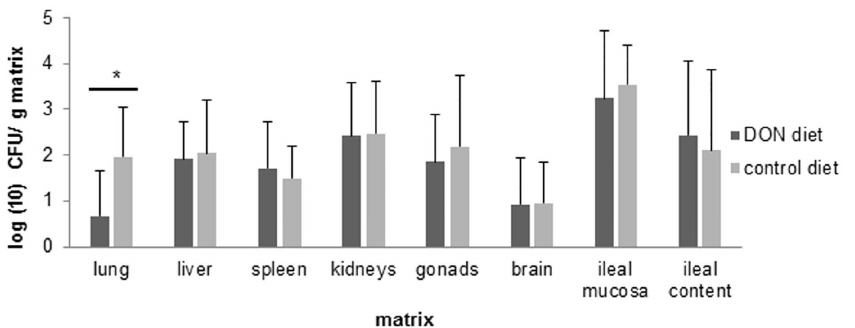
Fig 4. Salmonella numbers in organs. Thirteen days post inoculation with Salmonella Typhimurium variant Copenhagen strain DAB69, birds were euthanized and organs were collected,homogenized, and examined for the numberof CFU of Salmonella per gram of matrix. Results are presentedas mean +